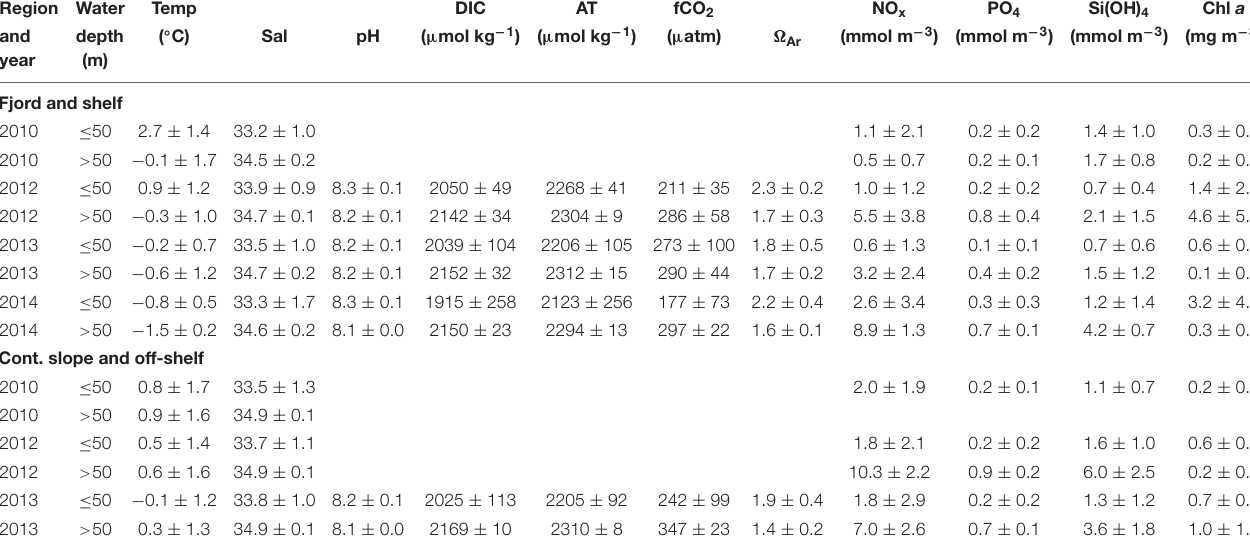
TABLE 1 | Overview of water chemistry parameters. Region